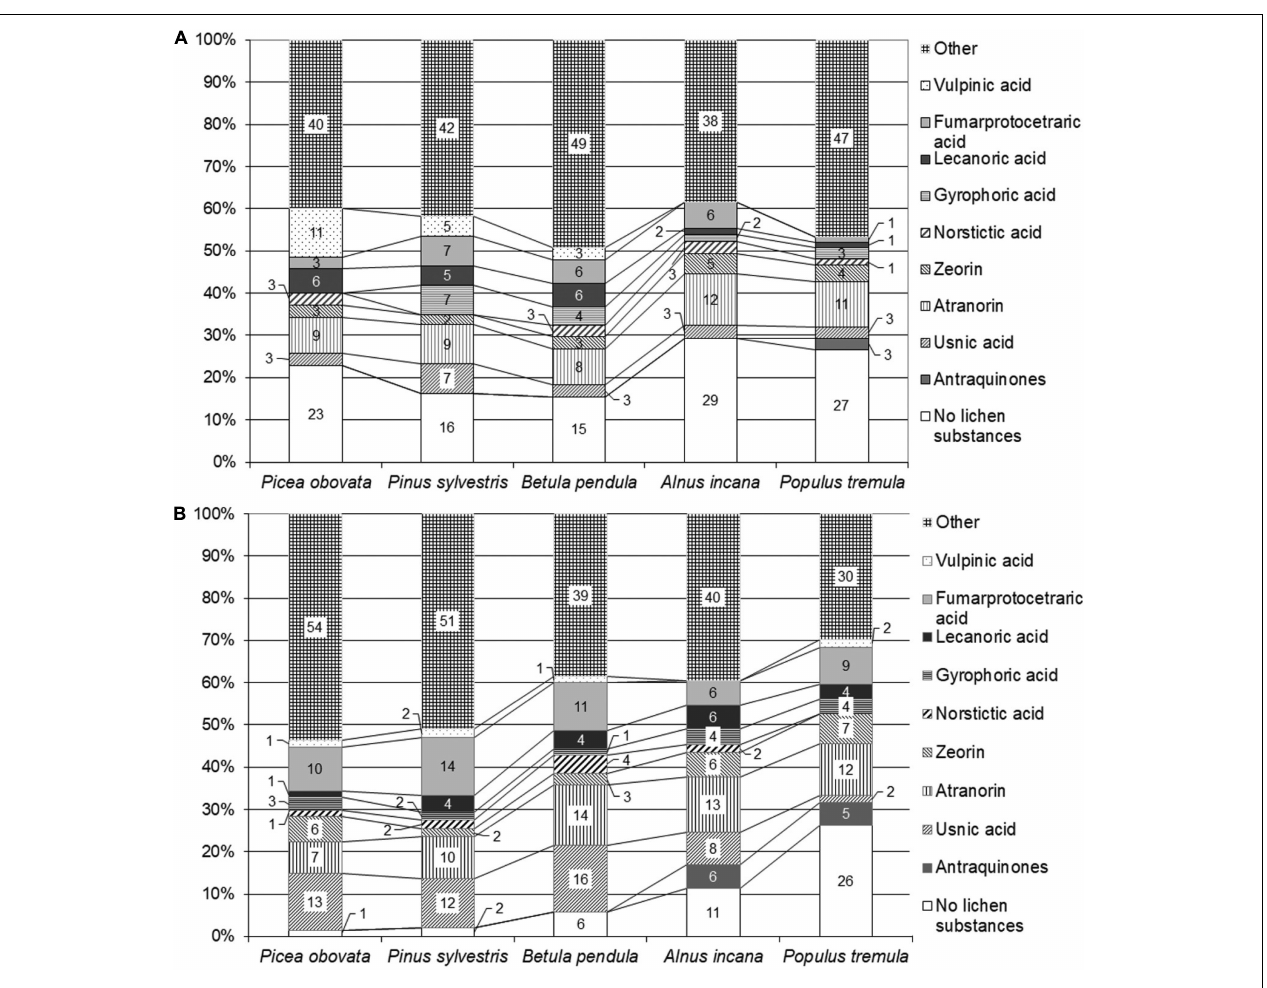
FIGURE 2 | Percentage of lichen species containing major secondary metabolites on different phorophytes. (A) Crustose species, (B) foliose and fruticose species.